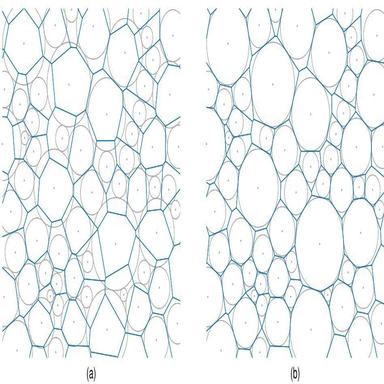
Granular system generated from an single arrangement of hard discs via the centroidal Voronoi tessellation (a) and the Laguerre-Voronoi tessellation (b).